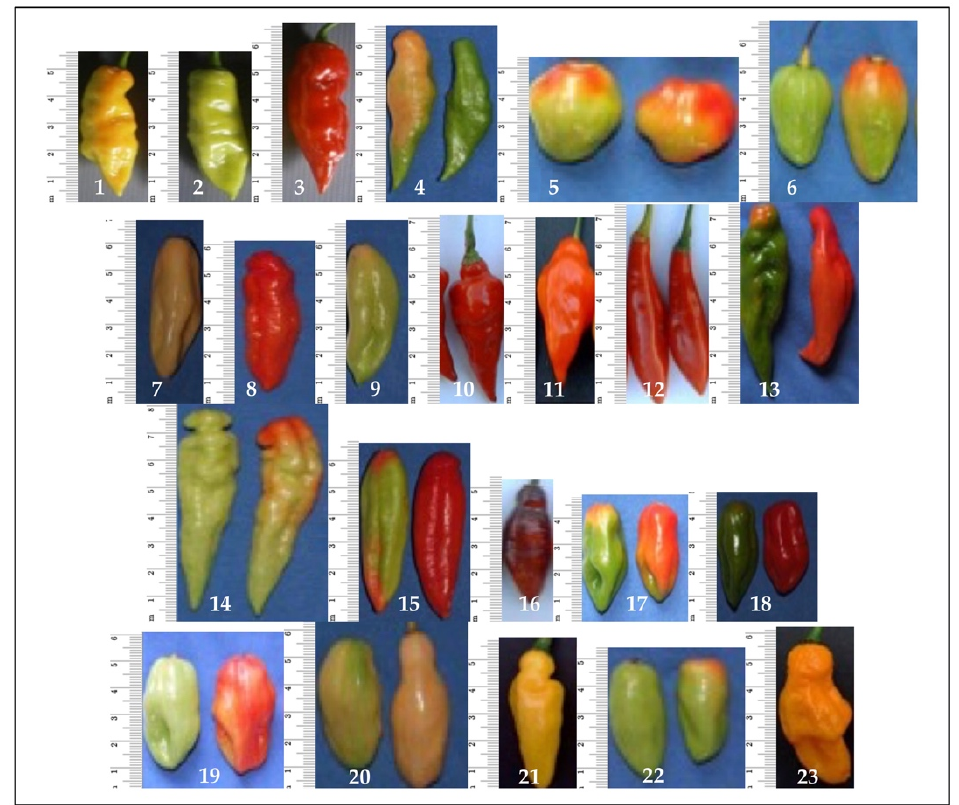
Figure 1. Samples of fruits from a plot the cultivated Capsicum chinense of Northern Brazil varieties: